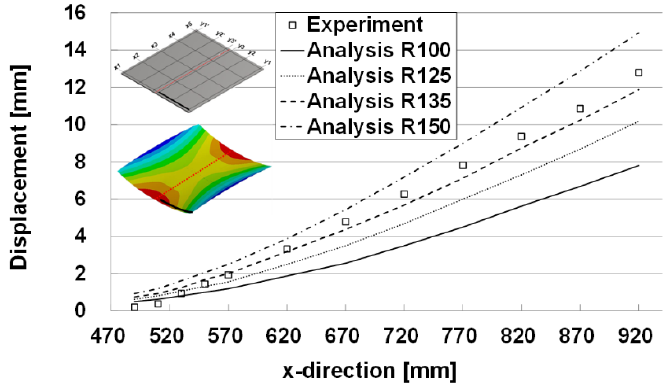
Figure 10. Angular bending deformation results by heat flux radius (x1).